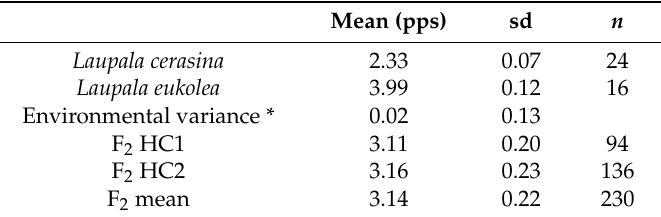
Table 1. Phenotypic distributions. The mean and standard deviation of the pulse rate (pulses per second) and the sample size are shown for the parental species and the F 2 generation (both cross types, HC1 and